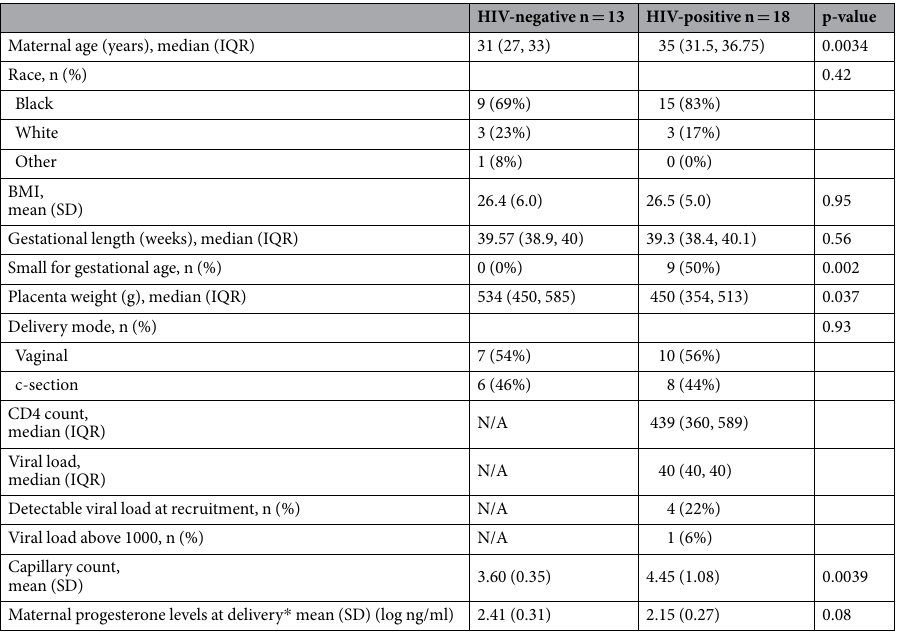
Table 1. Demographics and clinical characteristic of human stereology study. * n = 9 for HIV-negative and n = 12 for HIV-positive. IQR, interquartile range; SD, standard deviation; N/A, not applicable; BMI, body mass